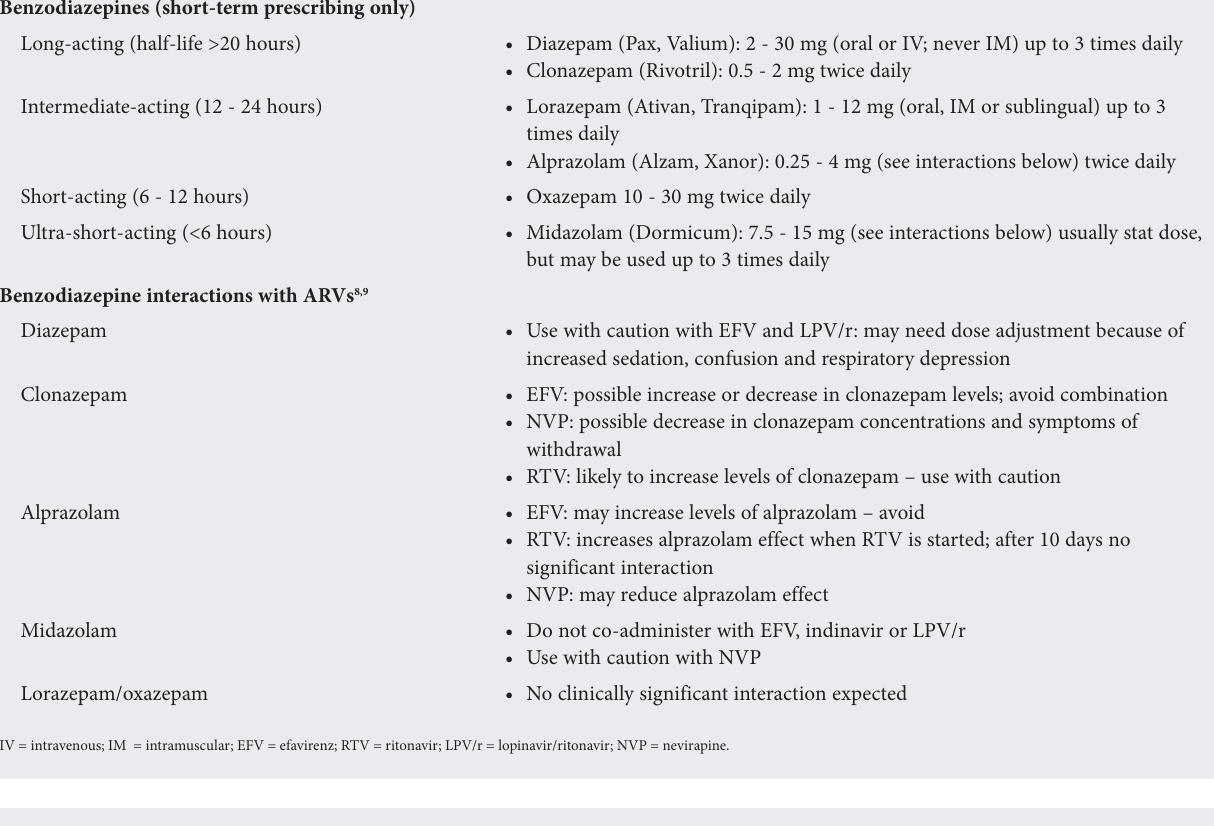
Table 4. Benzodiazepine use with ART Benzodiazepines (short-term prescribing only) Long-acting (half-life >20 hours)